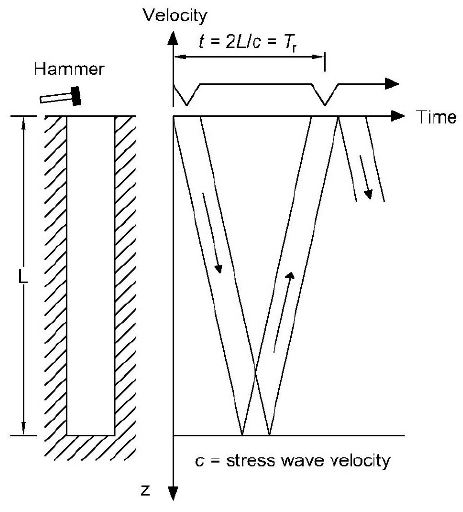
Figure 3. Intact and uniform pile.